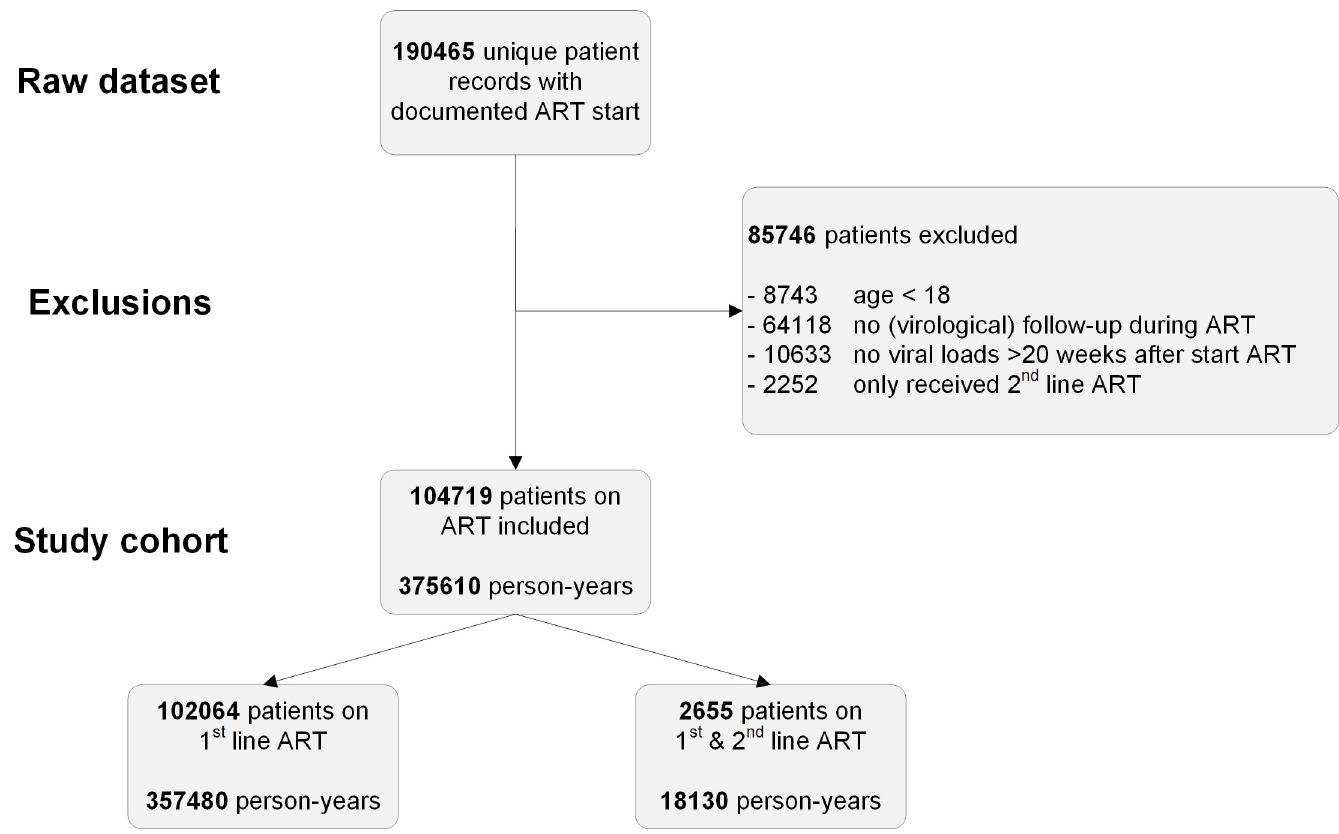
Fig 1. Patient inclusion. ART, antiretroviral